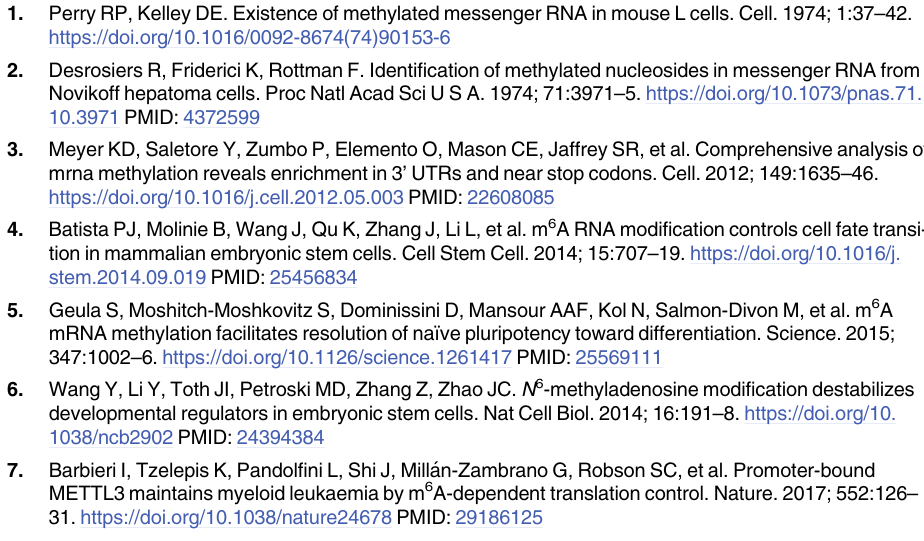
S2 Table. Sequences of METTL3 ORFs identified in exon2 Mettl3 KO mESCs. mESC, mouse embryonic stem cell; ORF, open reading frame. S3 Table. Sequences of Mettl3 mRNAs identified in polysome fractions. S4 Table. List of cell lines predicted to be m 6 A-independent. m 6 A, N 6 -methyladenosine. S5 Table. Primers used in this